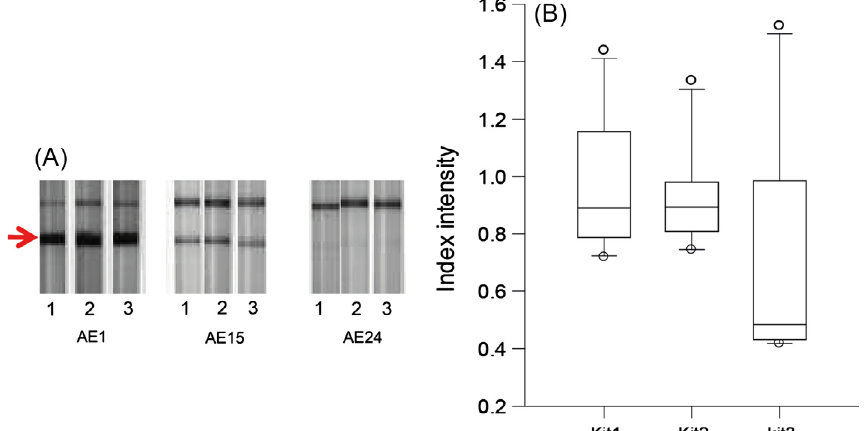
Figure 2. Test of reproducibility of rEm18-ICT using sera from 10 French AE (alveolar echinococcosis) patients, with three batches of kits (numbers 1, 2, and 3). (A) Strong, middle, and weak signals are shown for patients AE1, AE15, and AE24. The arrow shows the test band that indicates a positive test. (B) Index intensity values of three batches of kits; p <